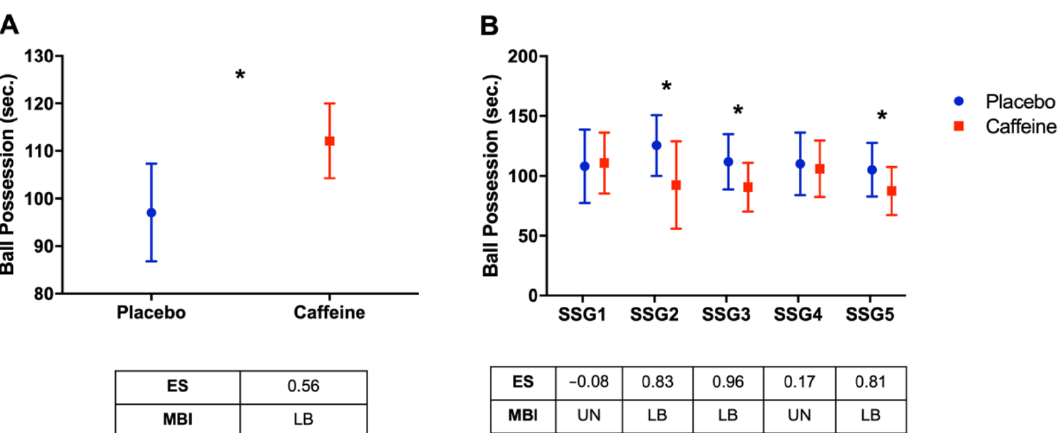
Figure 3. ( A ) Ball possession (total) in seconds; ( B ) ball possession in each SSG in seconds. * p <